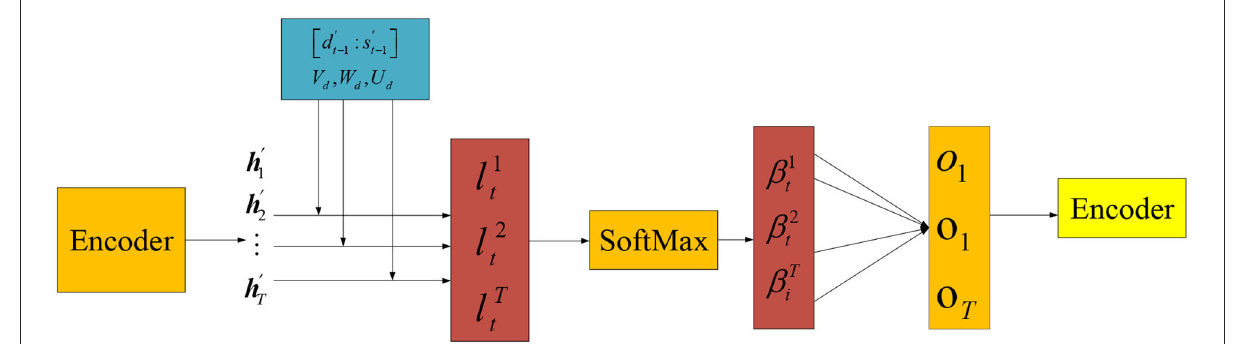
FIGURE7 Temporal AM.